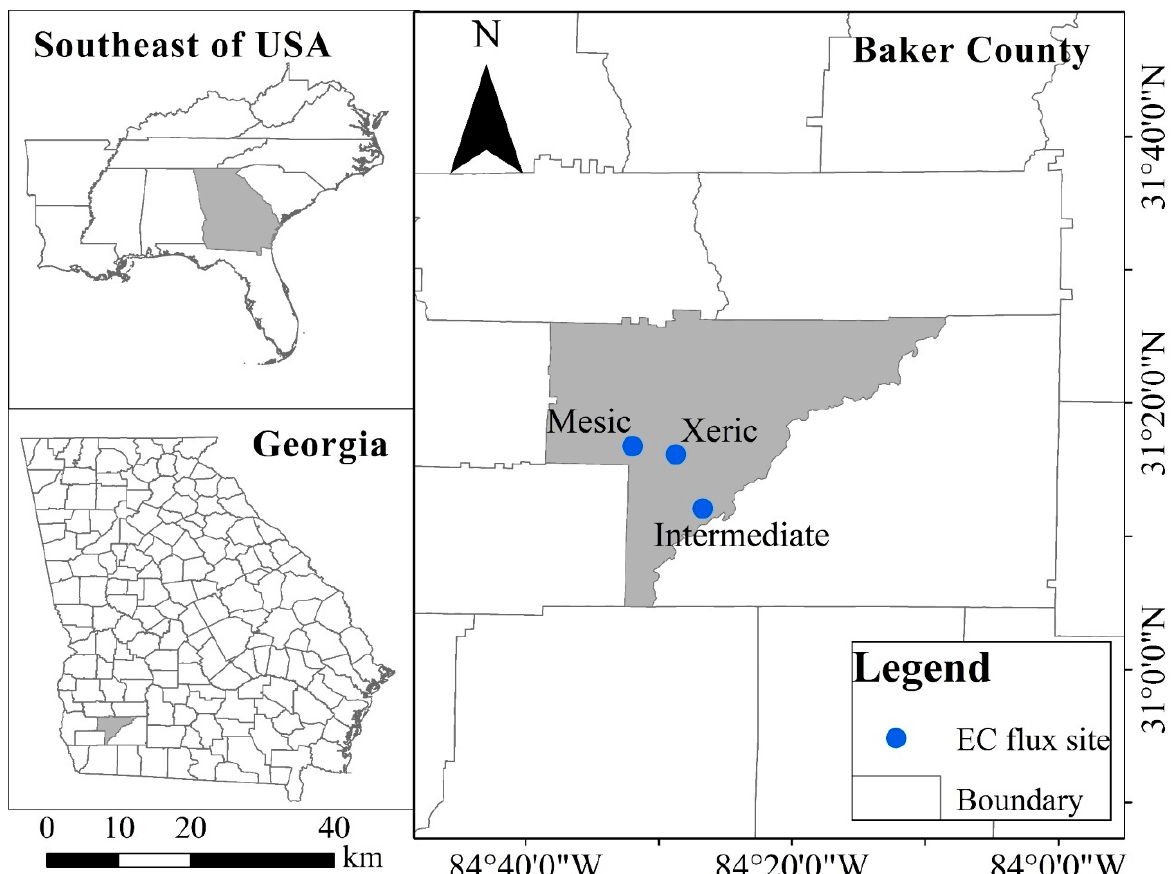
Figure 1. Geographical location map of three subtropical coniferous forest EC sites inside the JCI. Administrative boundary data downloaded from: USGS National Boundary Dataset (NBD, [41]), the geographic coordinate system of these map is GCS_WGS_1984 and visualized using ArcGIS version 10.2 (Environmental Systems Research Institute, Redlands, CA, USA).